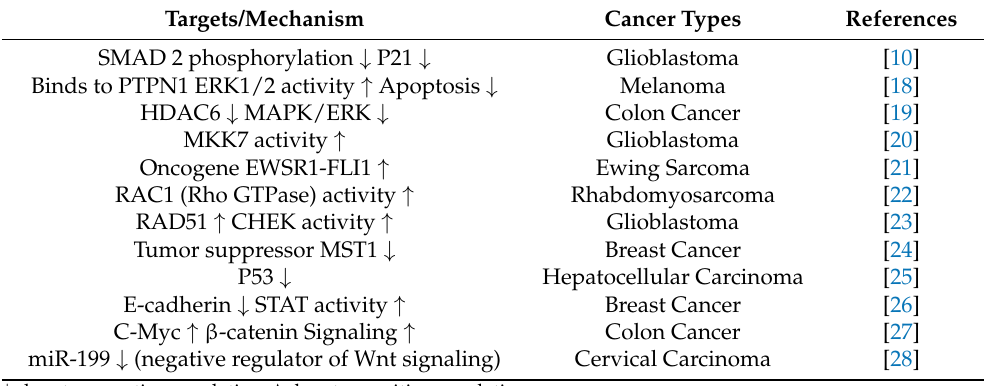
Table 1. Mechanism of HDAC6-promoted cancer cell proliferation.